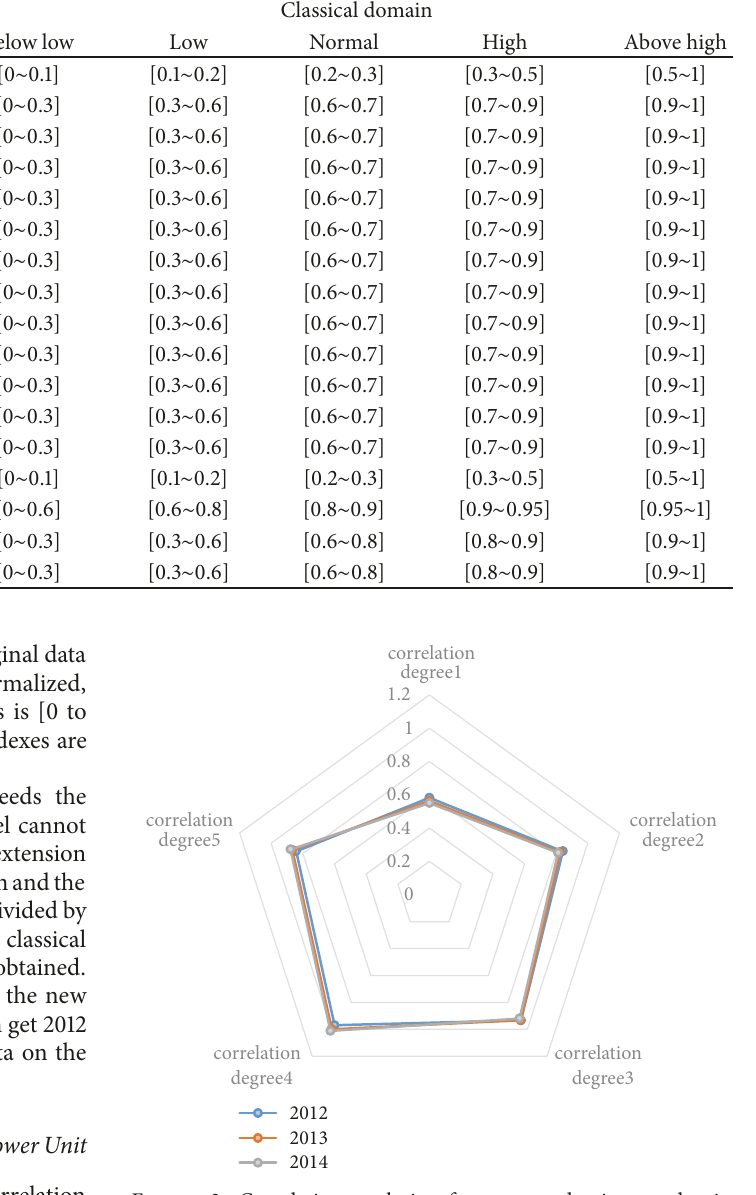
Figure 3: Correlation analysis of green production grades in thermal power plants from 2012 to